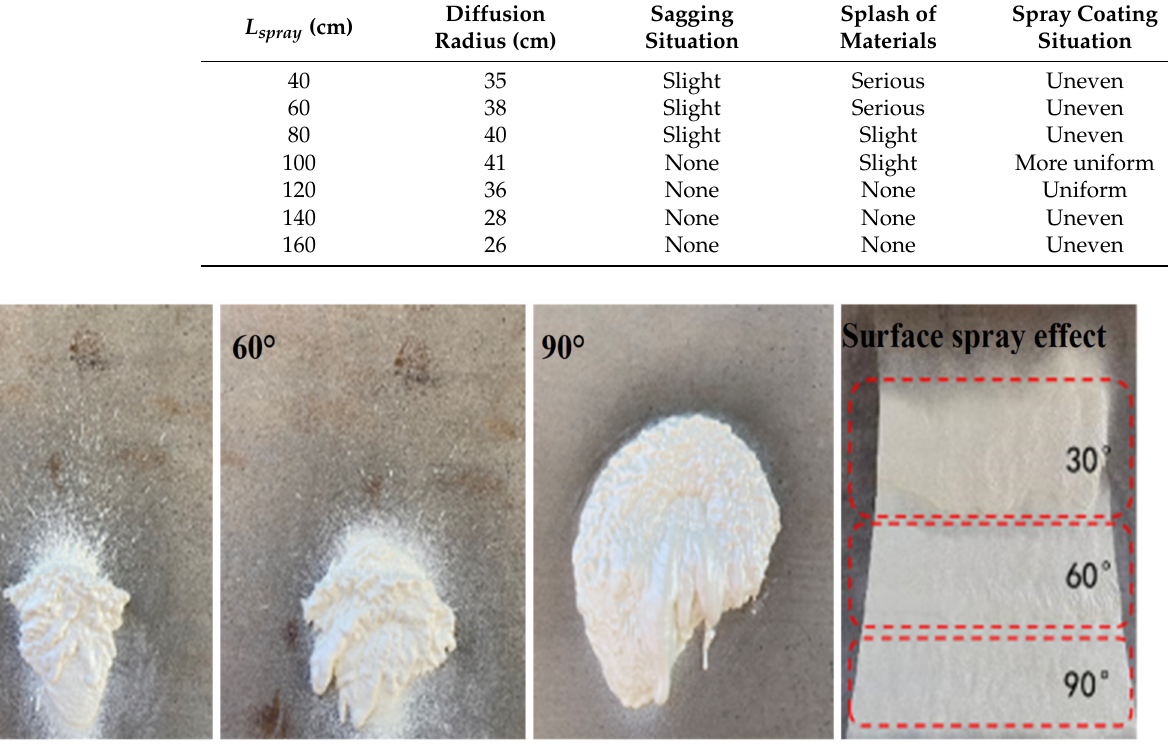
Figure 11. Spraying performance at different θ spray .